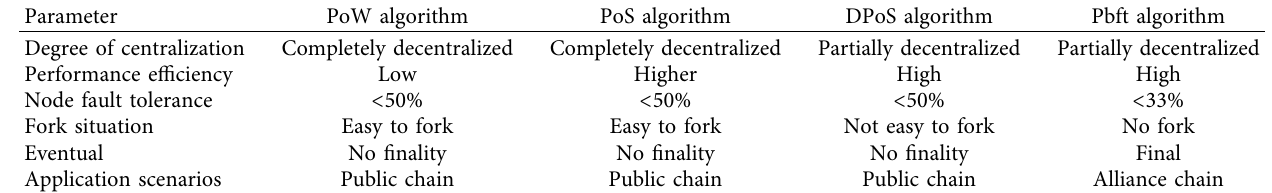
Table 3: The consensus algorithm comparison.